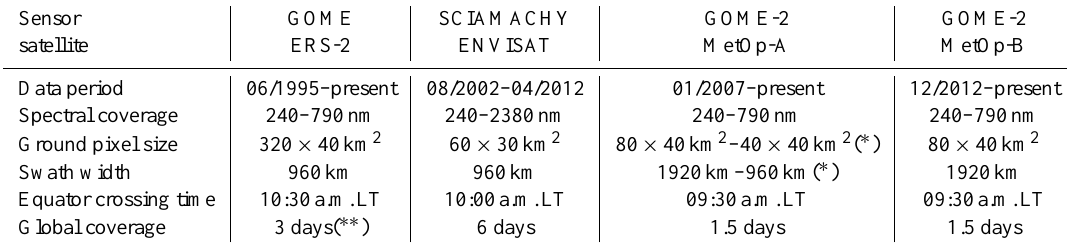
Table 1. Summary of the GOME-type instrument characteristics, illustrating the main improvement of GOME-2 compared to its predecessor GOME/ERS-2. ( ∗ ) GOME-2A tandem operation since 15 July 2013. ( ∗∗ ) GOME global coverage lost in June